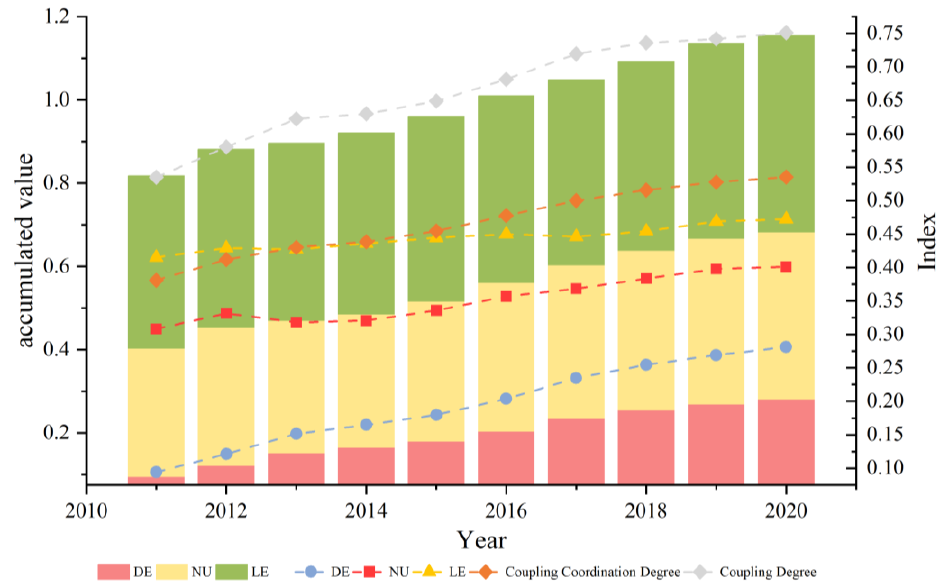
Figure 2. DE – NU – LE coordinated development trends in the Yangtze River Delta. Figure 2. DE–NU–LE coordinated development trends in the Yangtze River